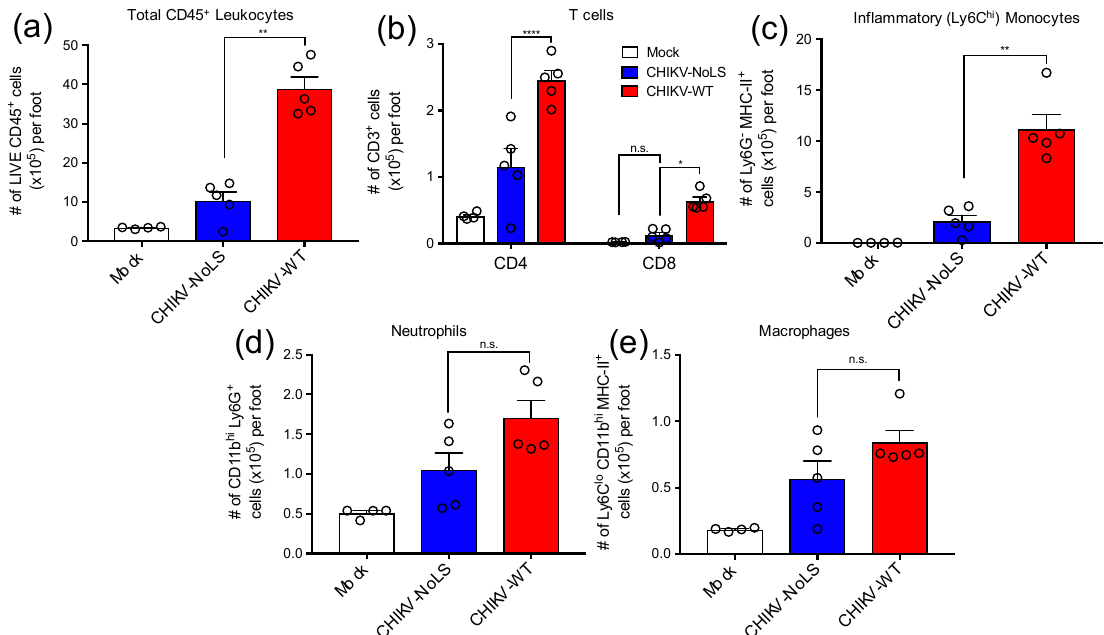
Figure 2. Cellular infiltrates in the feet of inoculated mice were analysed using flow cytometry. ( a ) Total live CD45 + leukocytes, ( b ) CD4 + and CD8 + T cells (CD3 + ), ( c ) inflammatory monocytes (Ly6C hi Ly6G - CD11b hi MHC-II + ), ( d ) Neutrophils (Ly6G hi CD11b hi ) and ( e ) tissue macrophages (Ly6C lo CD11b hi Ly6G - MHC-II + ). *, p < 0.05, **, p < 0.01, and ****, p < 0.0001. Statistical analyses were performed